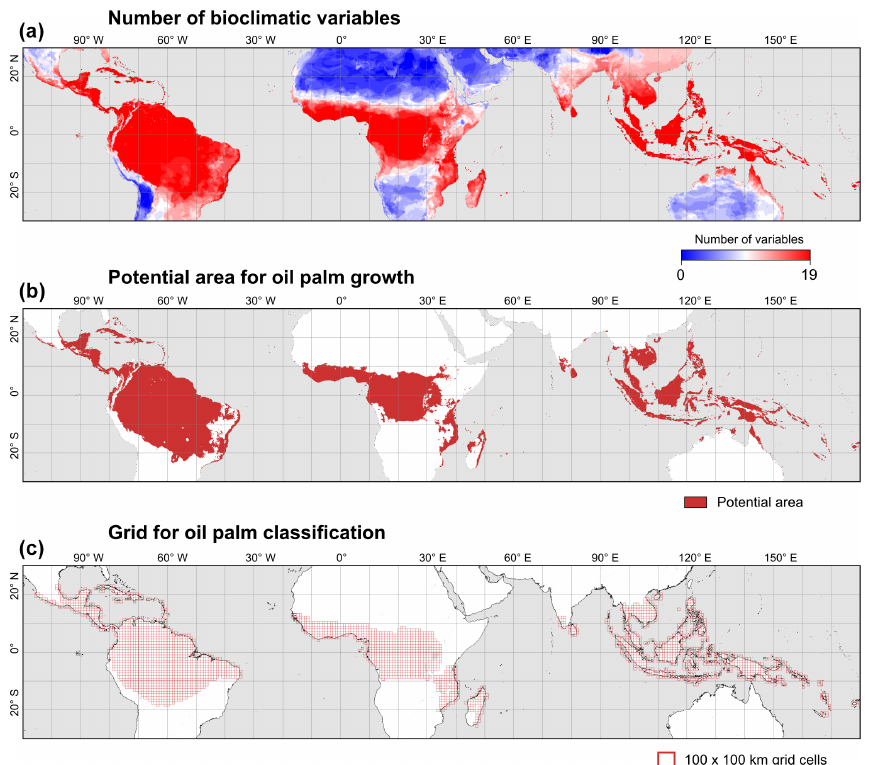
Figure A2. Maps generated for the estimation of the study area. The upper map (a) shows the number of WorldClim bioclimatic variables that fall within the range observed in the industrial oil palm plantations (IUCN layer). The middle map (b) shows the potential area for oil palm growth, which represents the pixels with more than 17 bioclimatic variables out of 19 falling within the range observed in the IUCN layer. The lower map (c) reflects the grid used to cover the study area.